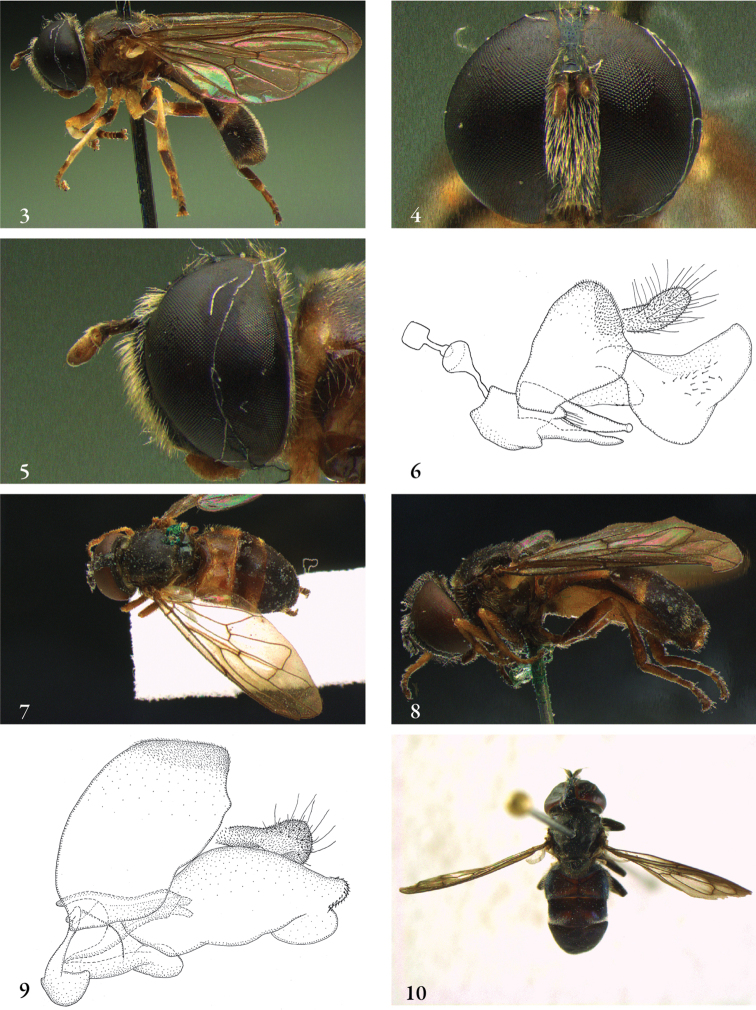
3–5
Afromicrodon madecassa male (holotype): 3 habitus dorsal 4 head frontal 5 head lateral 6
Afromicrodon johannae male (paratype), genitalia lateral 7–9
Archimicrodon (s.s.) simplicicornis male (holotype): 7 habitus dorsal 8 habitus lateral 9 genitalia lateral 10
Archimicrodon (s.s.) malukensis male (holotype), habitus dorsal.